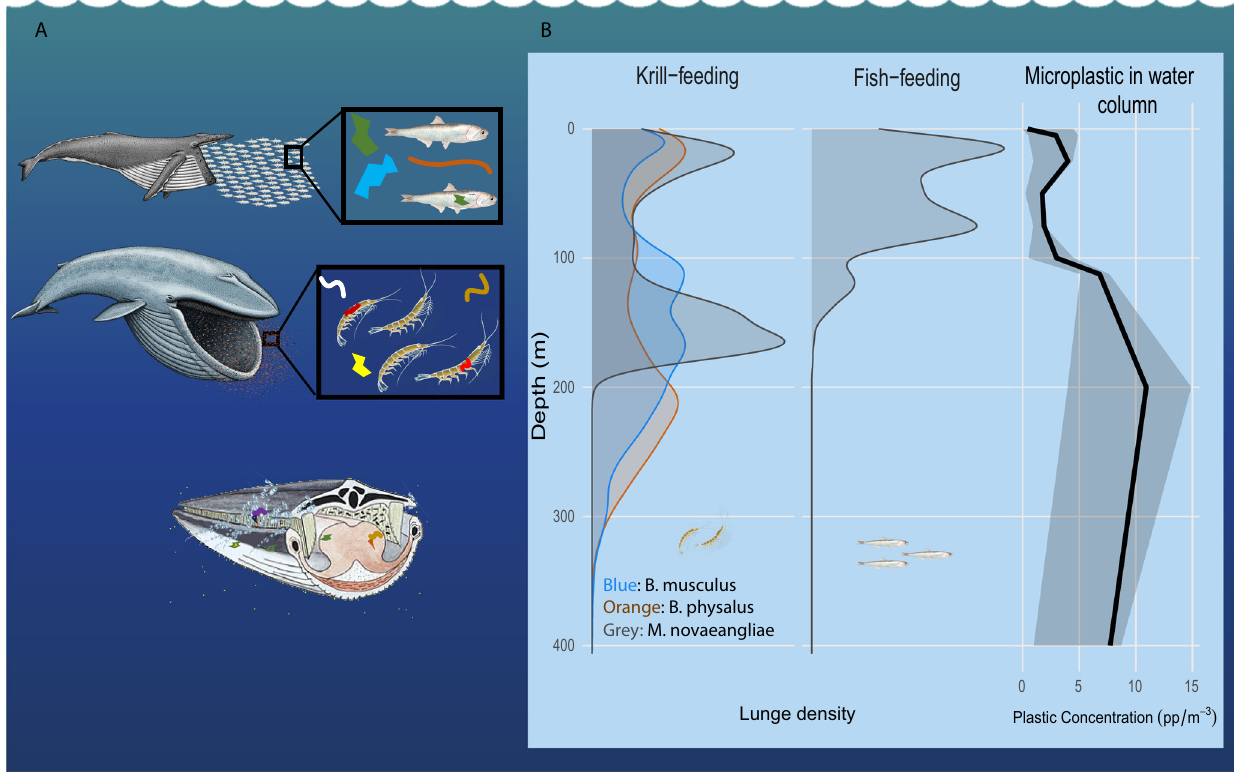
Fig. 1 |Depthofrorqualwhaleforaginginrelationto microplastic in thewater column.a Plasticingestedbywhalesday − 1 ,modeledasthesumof(i)plastic fi ltered from water per day and (ii) plastic consumed in prey per day. We created three scenarios to capture the range of possible exposure risk of plastic ingestion, low, medium, and high, since some of the variables lack comprehensive data; b Lunge